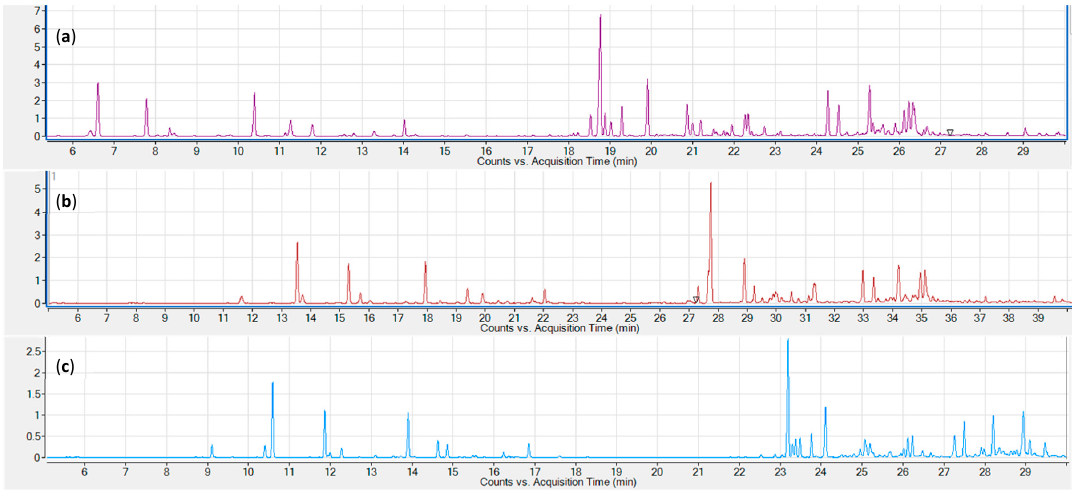
Figure 1. Comparison of three cannabis volatile sampling techniques. ( a ) static headspace; ( b ) solid- phase microextraction (SPME); ( c ) liquid extract (Hexane).